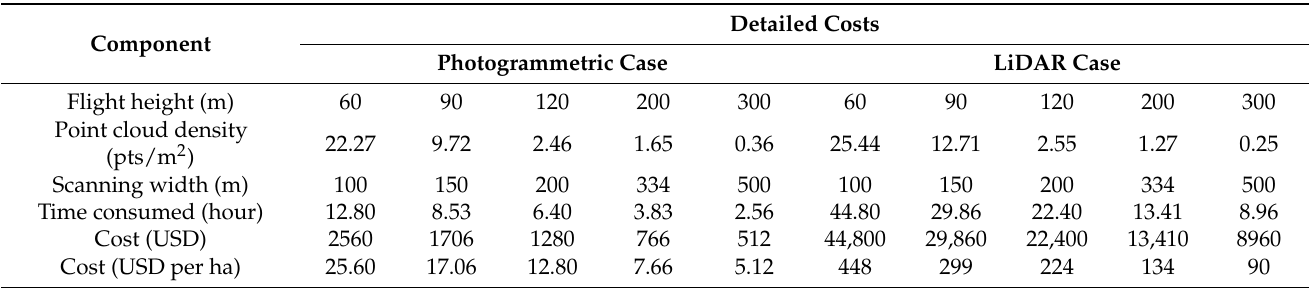
Table 11. Time and economic costs required for the LiDAR case and photogrammetric case used for mapping the plucking area of a 100 ha tea garden four